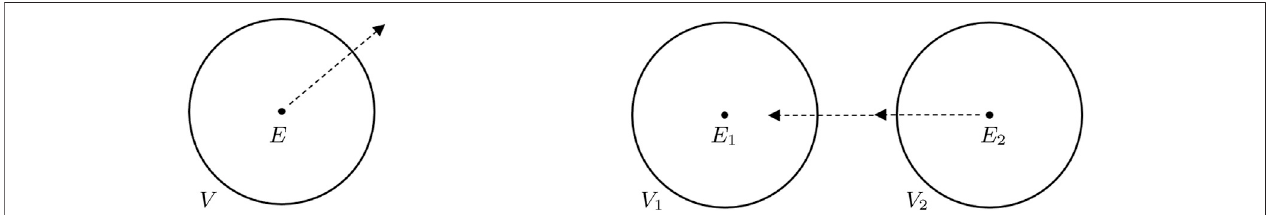
FIGURE1| Consequencesofazeroenergy fl ux.Left:consideraparticlewithenergy E enclosedbyavolume V .Iftheparticlecanmove,itcouldleave V andenergy inside V isnotconserved unless E =0.Iftheparticlecannotmove, thenthere canbeanon-zerorestenergy E 0 whichstaysinside V .Particledecayofaparticle withnon- zero rest energycan also not happen. Right: interactions are possible, but only between particlesof zero and non-zero energy, or between particles with zero energy. In this fi gure,particle2isattractedtoparticle1,buttobeconsistentwithzero-energy fl uxthrough V 2 ,itmusthavevanishingenergy E 2 =0.Whenitenters V 1 ,thetotal energy inside V 1 is then still conserved. Particle 1 is all the time at rest with rest energy E 1 . Under Carroll boosts, energies stay the same, but velocities are